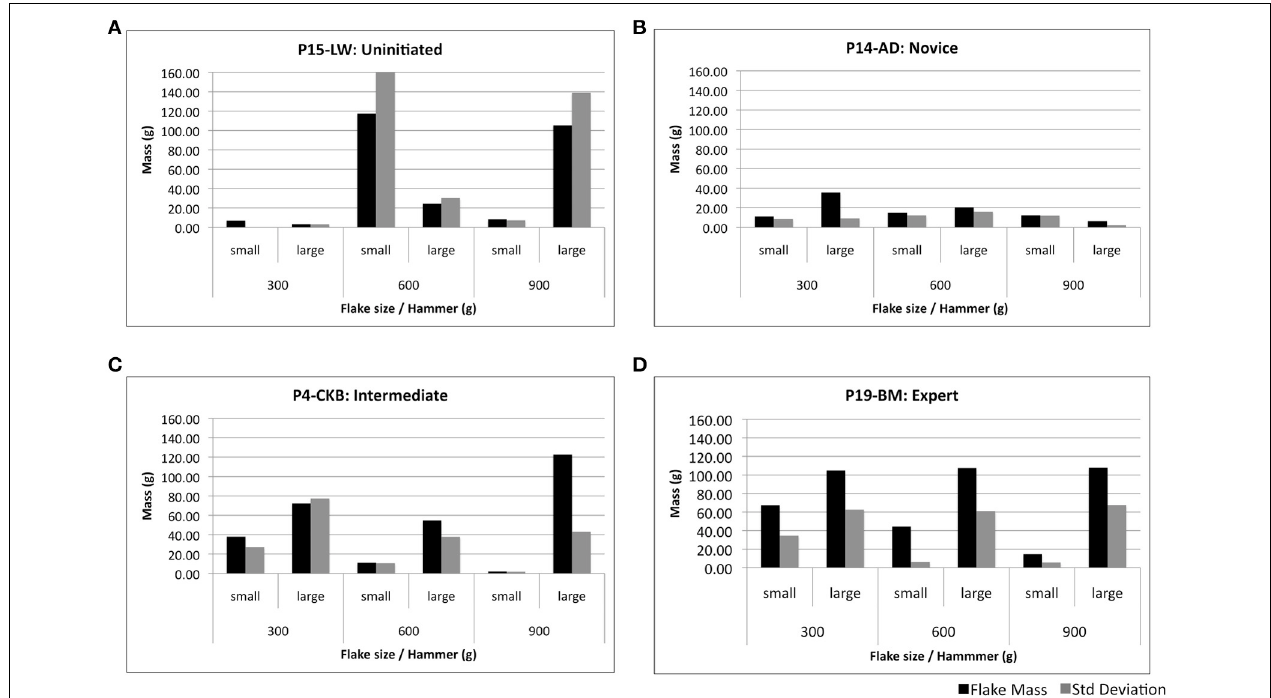
FIGURE 4 | Samples of task performance profiles used to validate level of expertise. An uninitiated subject (A) demonstrates limited ability to control flake mass. A typical novice subject (B) produces more regular flakes